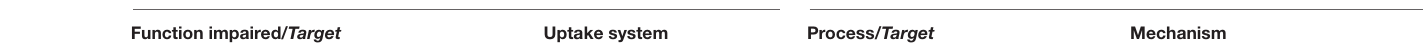
TABLE 2 | Comparison of the mechanisms involved in the antibacterial activity and the bacterial resistance for well characterized microcins and for conventional antibiotics sharing common targets with microcins.